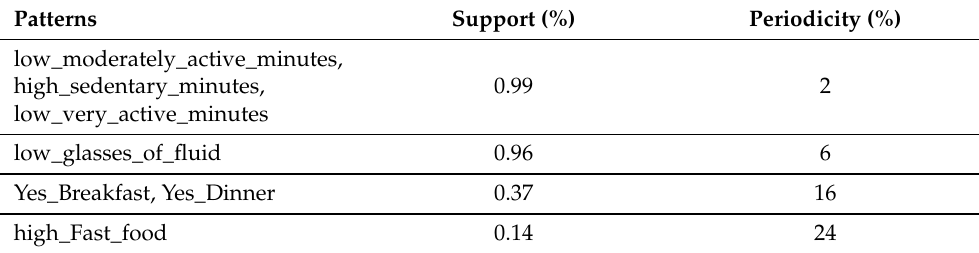
Table 5. Periodic-frequent pattern mining results for participant